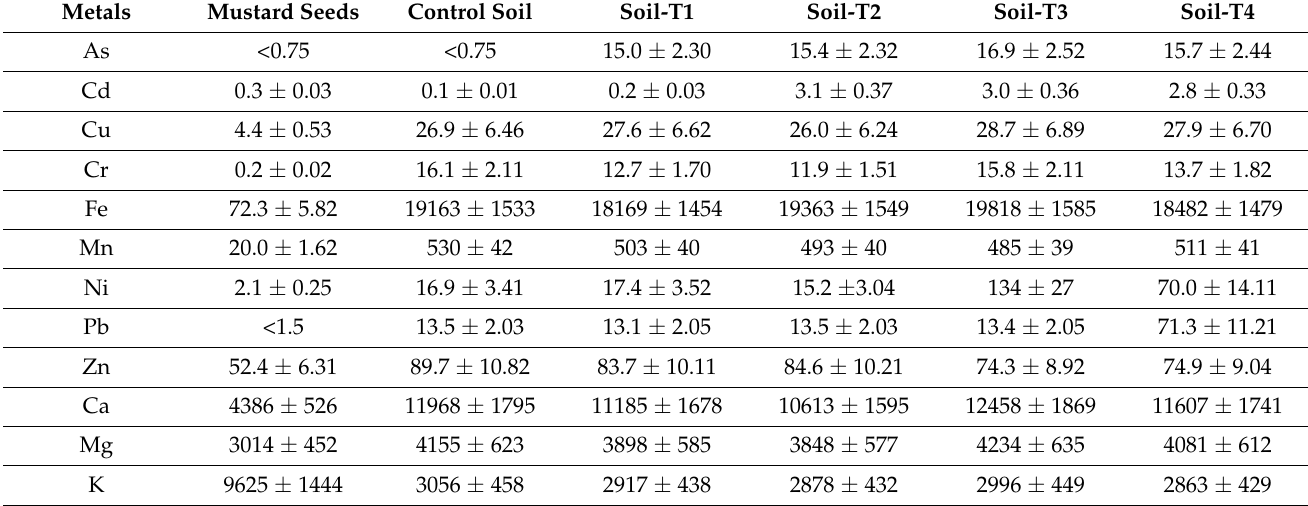
Table 4. Metal concentrations in mustard seeds, control and polluted soils, in mg kg − 1 d.w. (average ± ue, n = 3). Metals Mustard